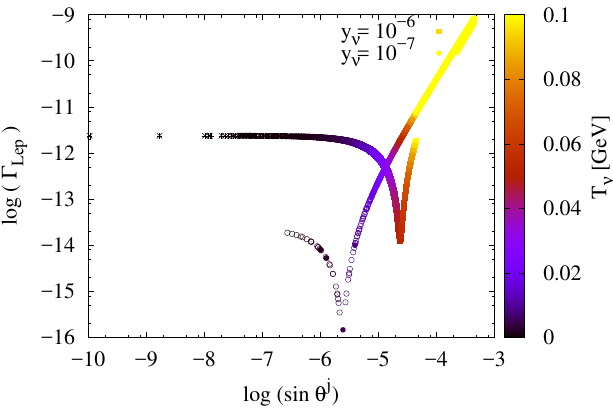
Figure 4 . Variation of the partial decay width of for M 1 = (cid:0) 1 : 5 TeV, M 2 = 1 : 8 TeV and gaugino fraction (cid:24) O (10 (cid:0) 2 ). Further, M R = 100 GeV, M L = 600 GeV, m soft = 100 GeV, (cid:22) = 300 GeV and tan (cid:12) = 5. The colored palette ~ (cid:23) 1 = 2